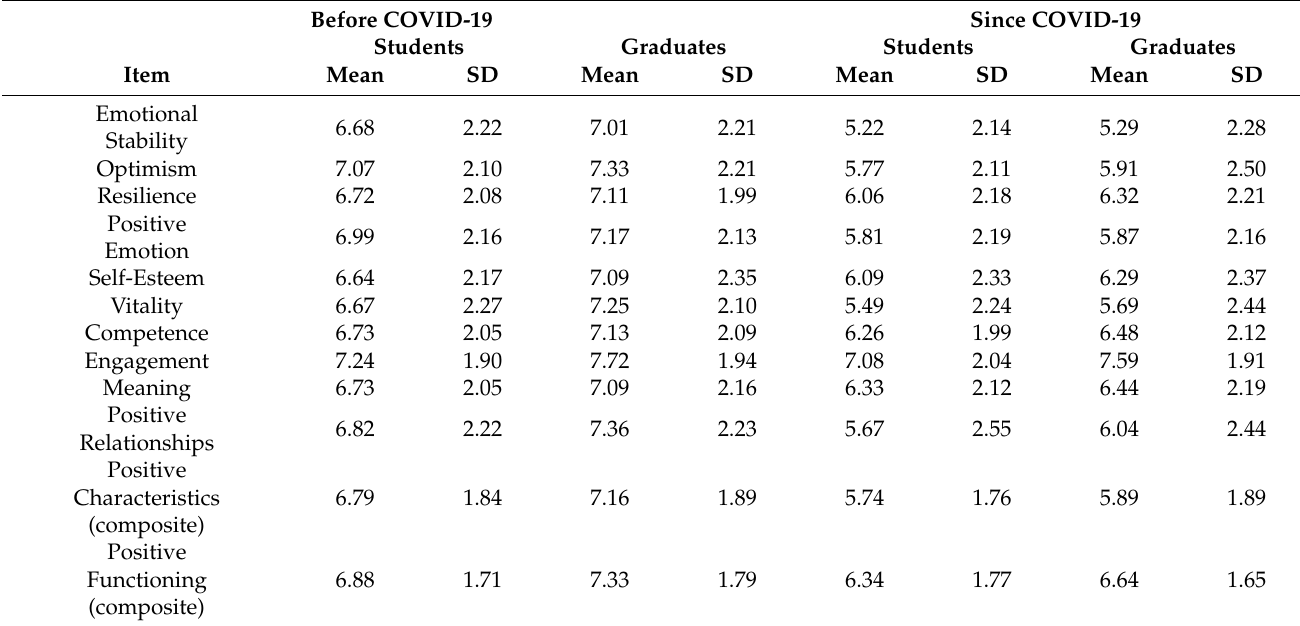
Table 3. Means and standard deviations before and since the COVID-19 pandemic for students and graduates (n =